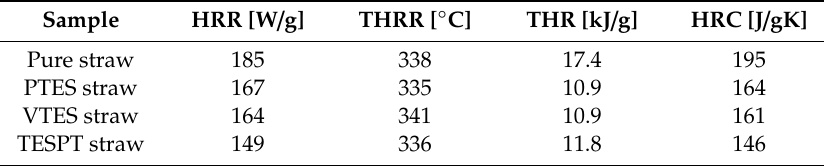
Table 6. Flammability results of unmodified and chemically modified cereal straw.